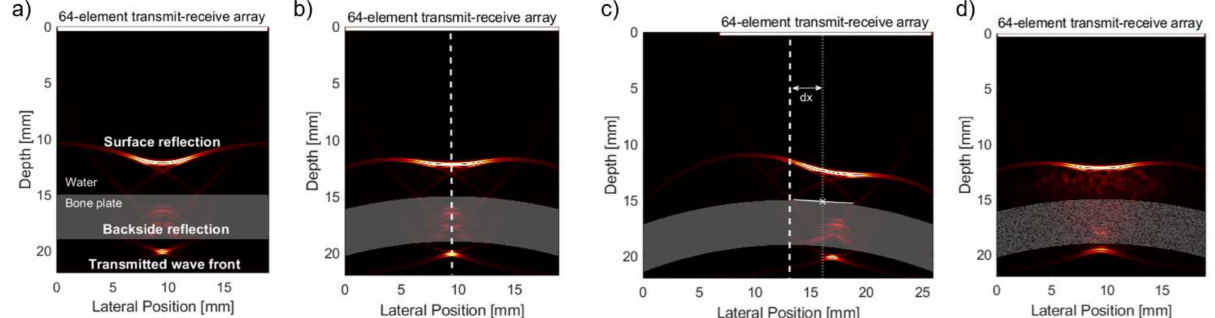
Figure 2. ( a ) Snapshot of the flat bone plate simulation model at 13.5 µ s. Transmitted and reflected wavefronts of a beam generated with a 64-element aperture and focused to a depth of 25 mm can be seen. ( b ) Snapshot of the curved plate model with a curvature radius of 40 mm. ( c ) Snapshot of the curved plate model r40dx3.11 with vertical bone symmetry axes being marked by a white dashed line, beam axis is shown by the grey dashed line, and the cross point of the beam axis with the frontside surface is marked as white. ( d ) Snapshot of r40dx0Po16 with a cortical porosity of 16% and pore diameter 60 µ m at focal depth of 25